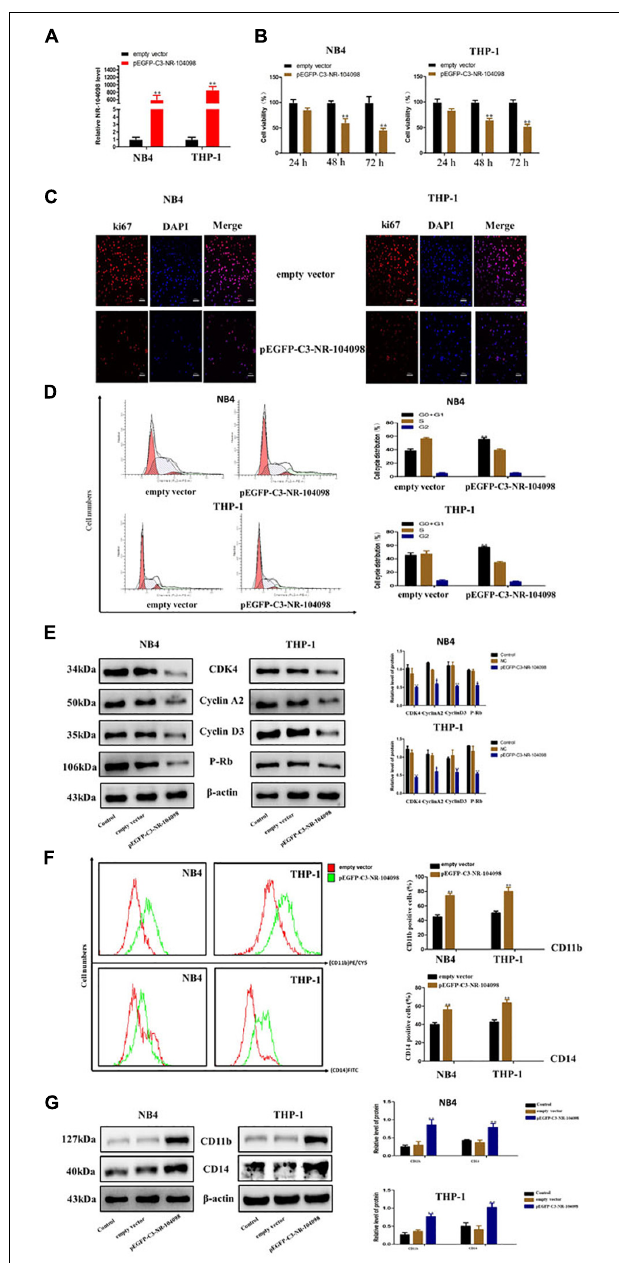
FIGURE 5 | LncRNA NR-104098 overexpression suppressed proliferation and induced differentiation of AML cells in vitro . (A) pEGFP-C3-NR-104098 or the empty vector was stably transfected into AML cells. 48 h later, overexpression efficient of lncRNA NR-104098 was evaluated by RT-qPCR. (B) pEGFP-C3-NR-104098 or the empty vector was transfected into AML cells for 24, 48, and 72 h respectively, and cell viabilities were assessed by CCK8 assay. (C) pEGFP-C3-NR-104098 or the empty vector was transfected into AML cells for 48 h, and ki67 protein expression was detected by immunofluorescence. (D) pEGFP-C3-NR-104098 or the empty vector was transfected into AML cells for 48 h, and the cell cycle were analyzed by flow cytometry. (E) Western blot analysis of cyclin D3, cyclin A2, P-rb, and CDK4 protein levels in AML cells after pEGFP-C3-NR-104098 or the empty vector was transfected into AML cells. (F) pEGFP-C3-NR-104098 or the empty